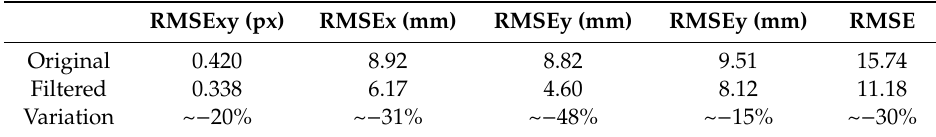
Table 18. Checkpoint RMSEs in the original and filtered sparse point cloud and variation of the obtained values.